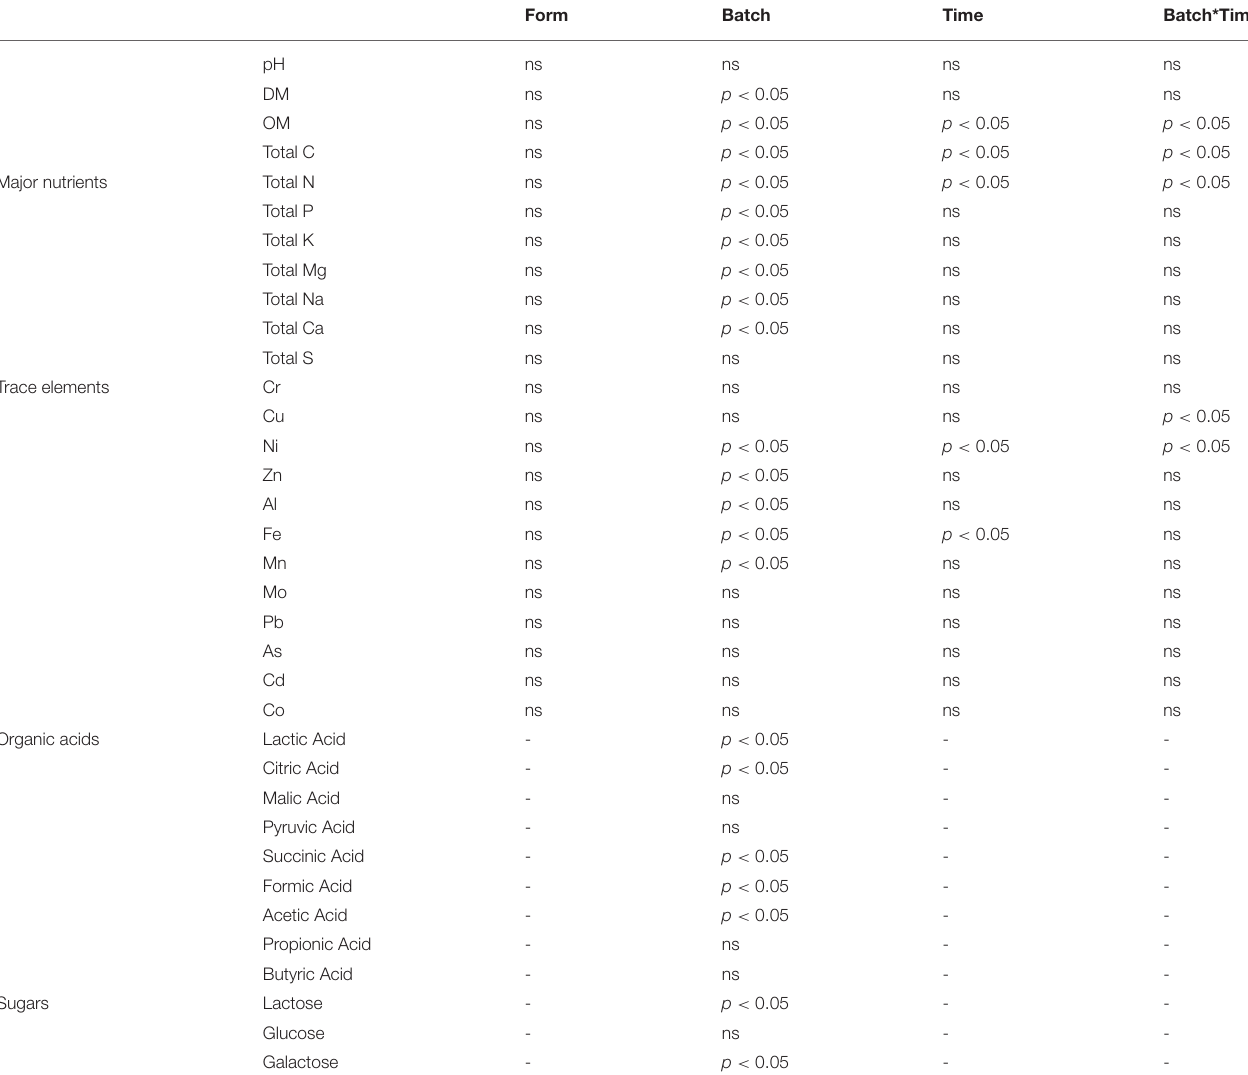
TABLE 3 | Factorial ANOVA used to evaluate the differences between lacto-gypsum batches, time of storage, form of storage and their interactions for dry matter, organic matter, pH, major nutrients and trace